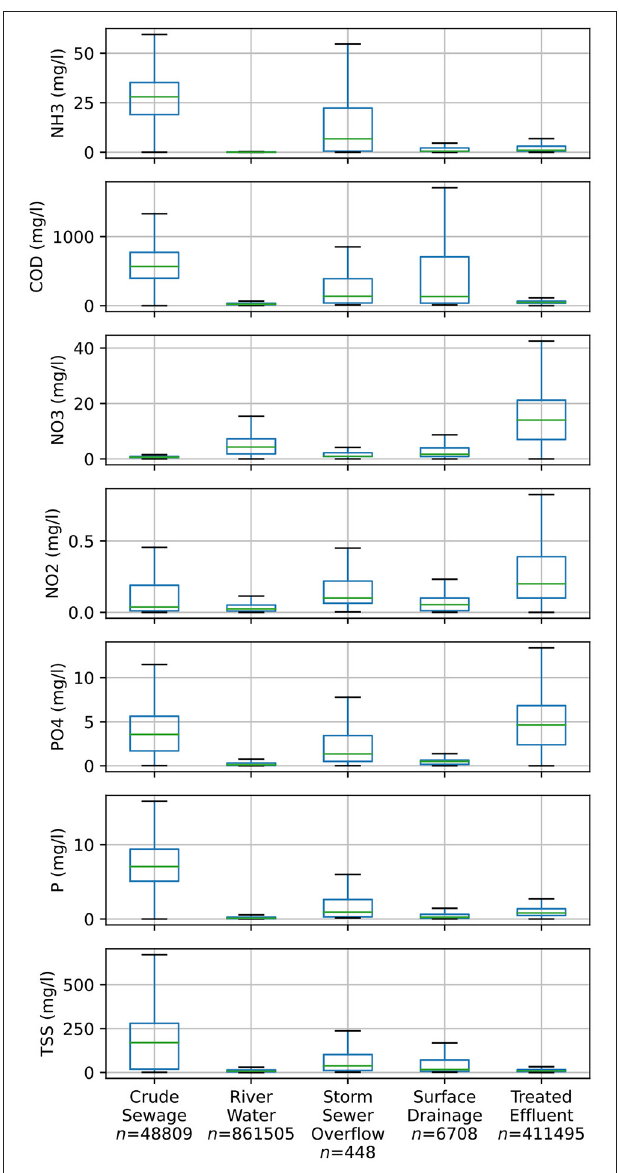
FIGURE 5 | The pollution content of every sample in the WIMS database, sorted by sample material (i.e., each column) for the pollutants considered in this study (each pollutant is a row). Green bars indicate the median value, boxes the interquartile range (IQR) and whiskers indicate the range of measurements that are ± IQR*1.5 within the upper and lower quartiles. Measurements that fall outside of the whiskers are not shown to improve the readability of plots. The average number of samples across the presented pollutants is indicated for each sample material by